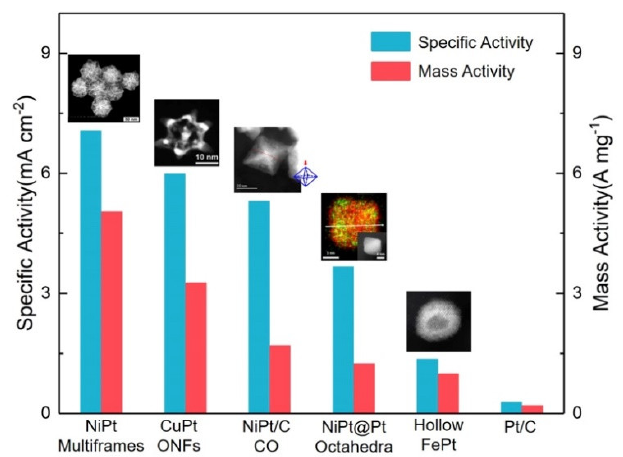
Figure 11. Comparison of various type of oxygen reduction reaction (ORR) Pt alloyed nanocatalysts that are reported in recent two years, including NiPt Multiframes [100], CuPt octopod nanoframes (ONFs) [99], NiPt/C concaved octahedra (CO) [32], NiPt@Pt ocathedra [94], hollow FePt [96], and 20% Pt/C [96]. Inset images, from left to right were reprinted with permission from reference